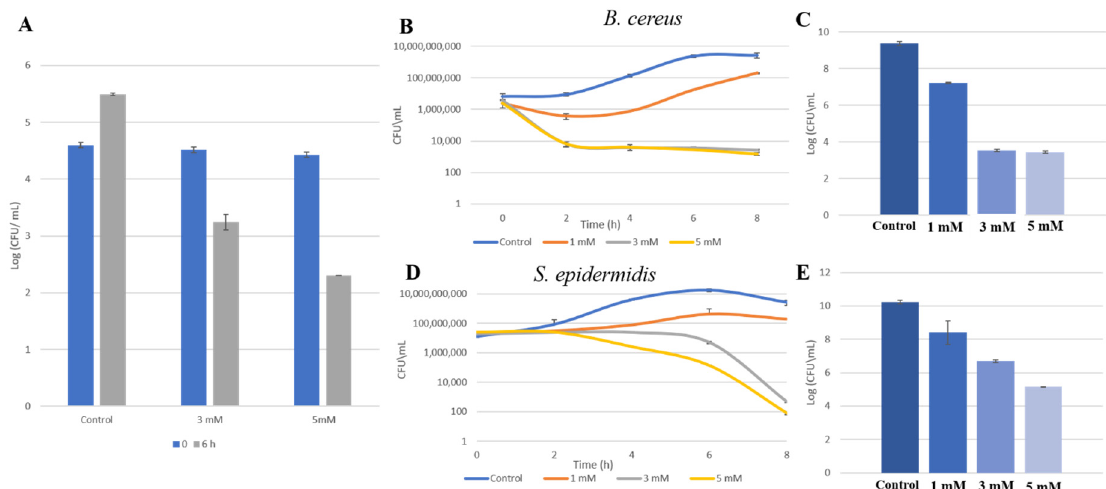
Figure 2. Antimicrobial effect Zn 2+ ions on bacterial contaminants in human milk (HM). The effect of Zn 2+ ions on growth of aerobic bacterial population in HM; growth was measured after 6 h of incubation of raw HM, with or without the addition of zinc ( A ). Growth curve analysis of B. cereus ( B ) and S. epidermidis ( D ) cells isolated from HM grown for 8 h with various concentrations of zinc in Lysogeny broth (LB) medium. Bacterial levels of B. cereus ( C ) and S. epidermidis ( E ) grown with or without zinc in pasteurized HM after 8 h. p -value < 0.05, compared with control. Error bars represent standard deviation (SD). CFU = colony-forming units.